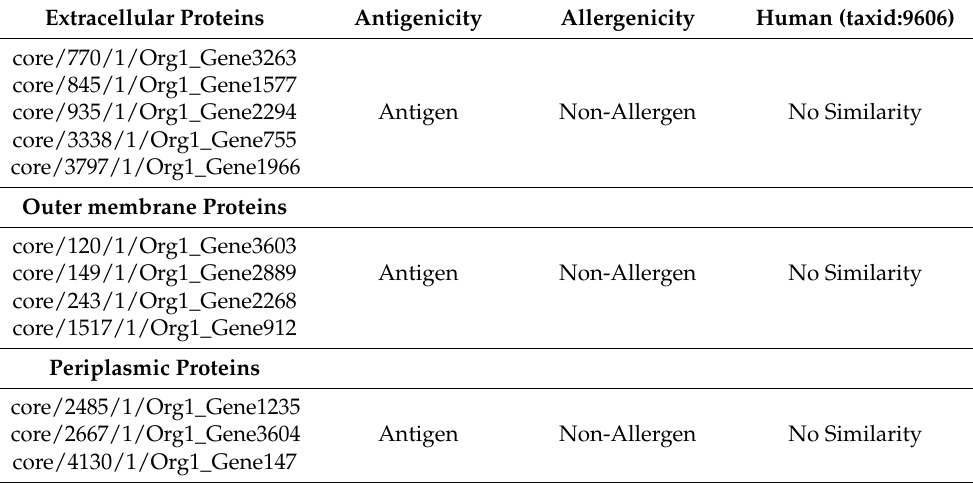
Table 4. Lists the proteins that are non-similar, antigenic, and non-allergic to hosts. Extracellular